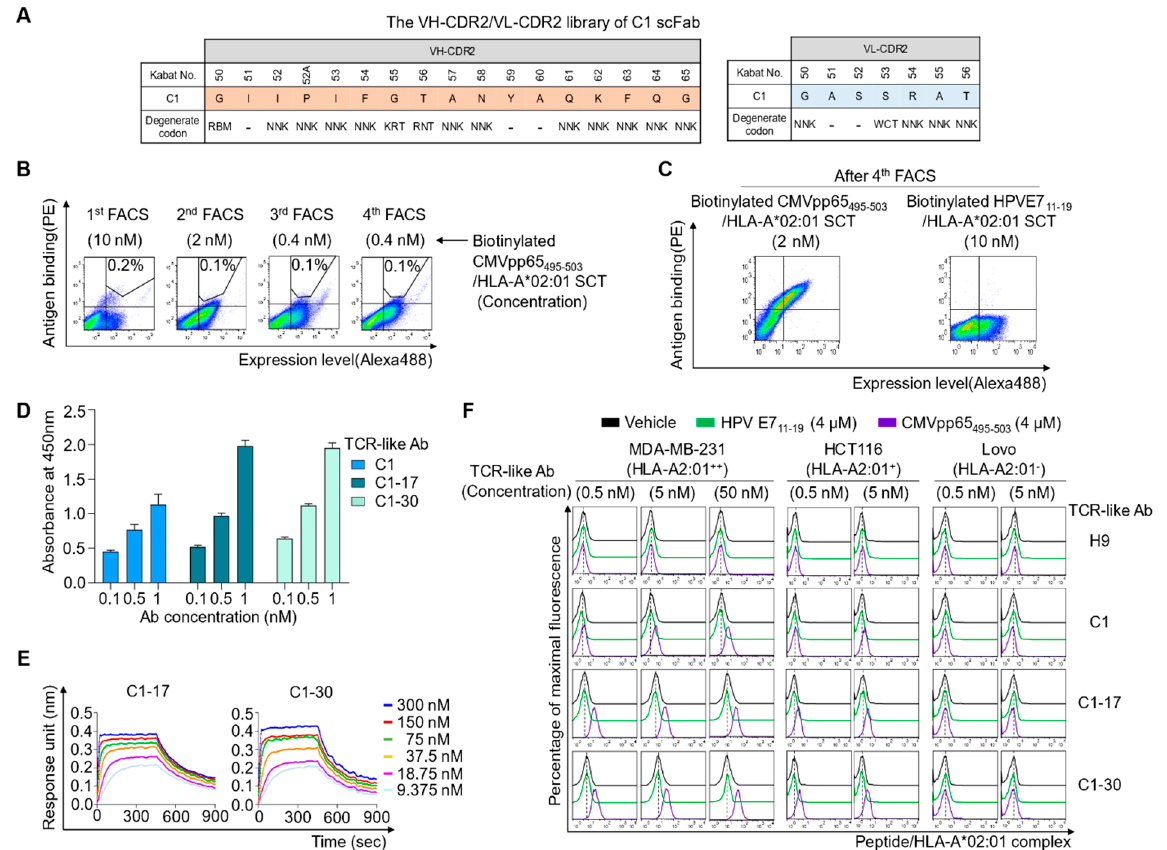
Figure 3. Affinity maturation of C1 Ab to generate high-affinity TCR-like Abs. ( A ) The scheme of yeast scFab library construction for VH-CDR2 and VL-CDR2 of C1 Ab, wherein the indicated residues were randomized with the indicated degenerate codons. The “-” sign indicates conserved residues. ( B ) Flow cytometric sorting gate plots of the yeast surface- displayed scFab library screening in each round of screening by FACS with the indicated concentration of the biotinylated CMVpp65 495-503 /HLA-A*02:01 SCT antigen in the presence of a 10-fold higher concentration of the non-biotinylated off-target HPVE7 11-19 /HLA-A*02:01 SCT protein. ( C ) Flow cytometric analysis of target-specific enrichment for the yeast surface-displayed scFab library pool enriched after four rounds of FACS using the indicated target and off-target antigen. ( D ) Dose-dependent binding activity of the isolated and purified Abs in mouse IgG2a/ κ form toward the microtiter plate coated with pMHC comprising CMVpp65 495-503 /HLA-A*02:01 complex antigen, as determined by ELISA. ( E ) Binding isotherms of the immobilized IgG2a/ κ Abs toward the soluble CMVpp65 495-503 /HLA-A*02:01 complex antigen, as measured by biolayer interferometry. The concentrations of pMHC are indicated (colored). The kinetic interaction parameters are listed in Table 1. ( F ) Flow cytometric analysis of binding of the TCR-like Abs in IgG2a/ κ form at the indicated concentrations to peptide-pulsed cells. Cells were pulsed for 3 h at 37 ◦ C with the vehicle, CMVpp65 495-503 peptide (4 µ M), or the control, HLA-A*02:01-restricted HPVE7 11-19 (4 µ M) peptide, and incubated with the TCR-like Abs at the indicated concentrations and then with the Alexa Fluor 647-conugated goat anti-mouse IgG-specific (Fab’) 2 Ab (secondary Ab) prior to flow cytometry. Representative histograms from two independent experiments are